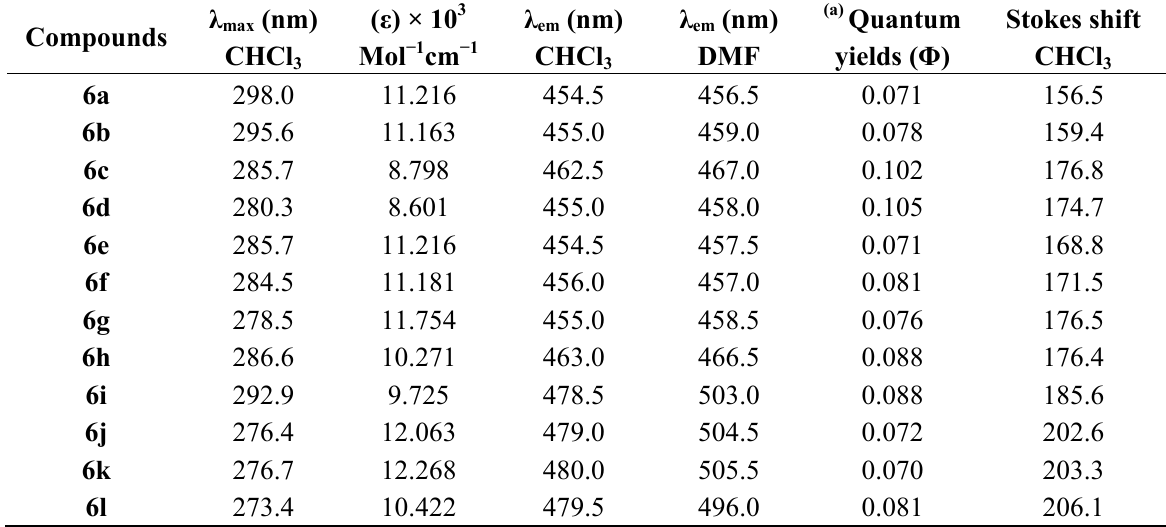
Table 1. The absorption and emission data for compounds 6a – l